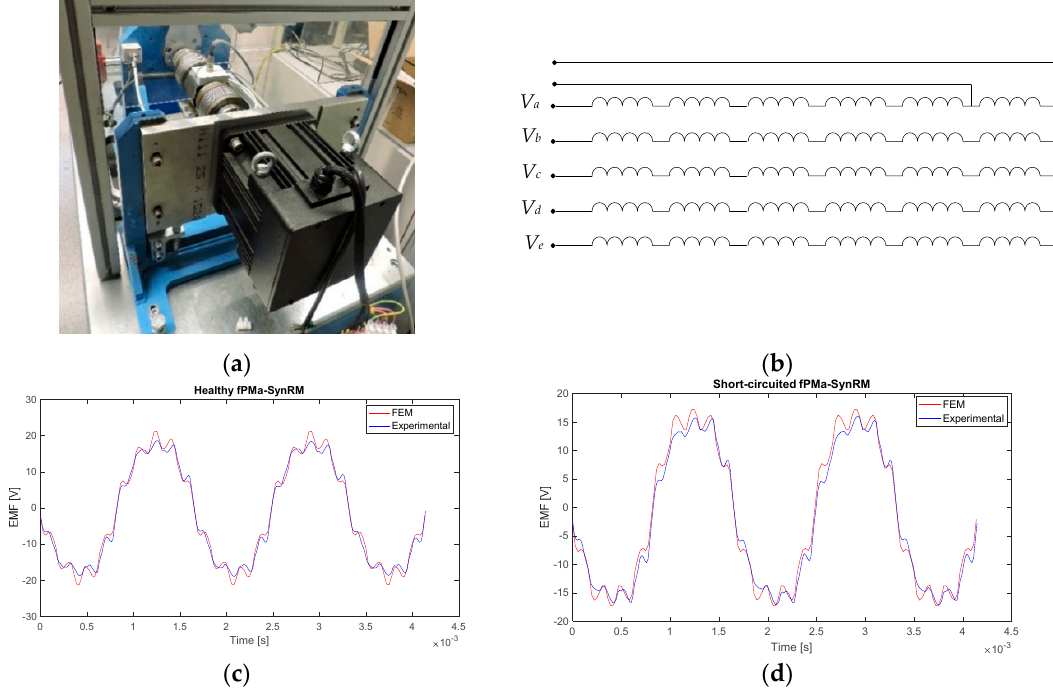
Figure 3. Comparative results between the experimental and simulated electromotive force ( emf ) when the machine runs as a generator under no-load conditions at 1000 rev/min. ( a ) Test setup. ( b ) Layout of the stator windings, which allow short-circuiting of one of the poles in phase a . ( c ) Electromotive force of one of the phases under healthy conditions. ( d ) Electromotive force of the short-circuited phase under faulty conditions when one pole is short-circuited.